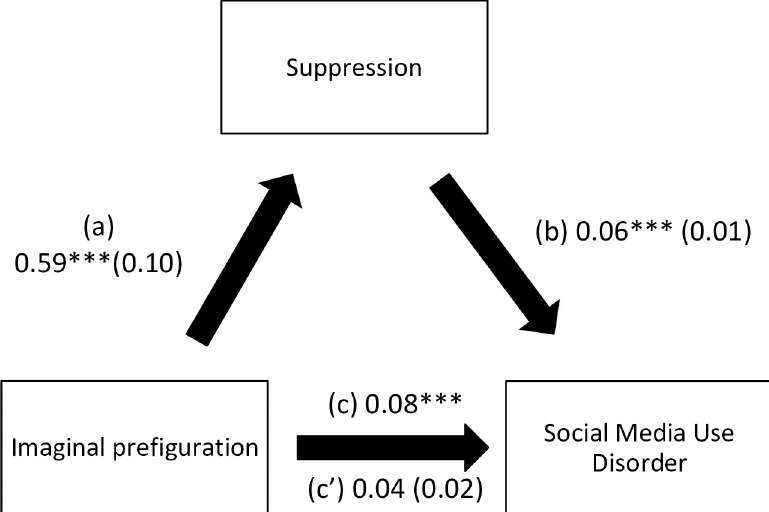
Fig 3. (a) Relation between imaginal prefiguration and suppression (R 2 = 20.38%); (b) Relation between suppression and social media use disorder (R 2 = 13.92%); (c) Total effect of the relation between imaginal prefiguration and social media use disorder (R 2 = 9.55%); (c’) Direct effect of the relation between imaginal prefiguration and social media use disorder. Numbers are displayed as regression coefficients (standard error). ��� p < 0.001.